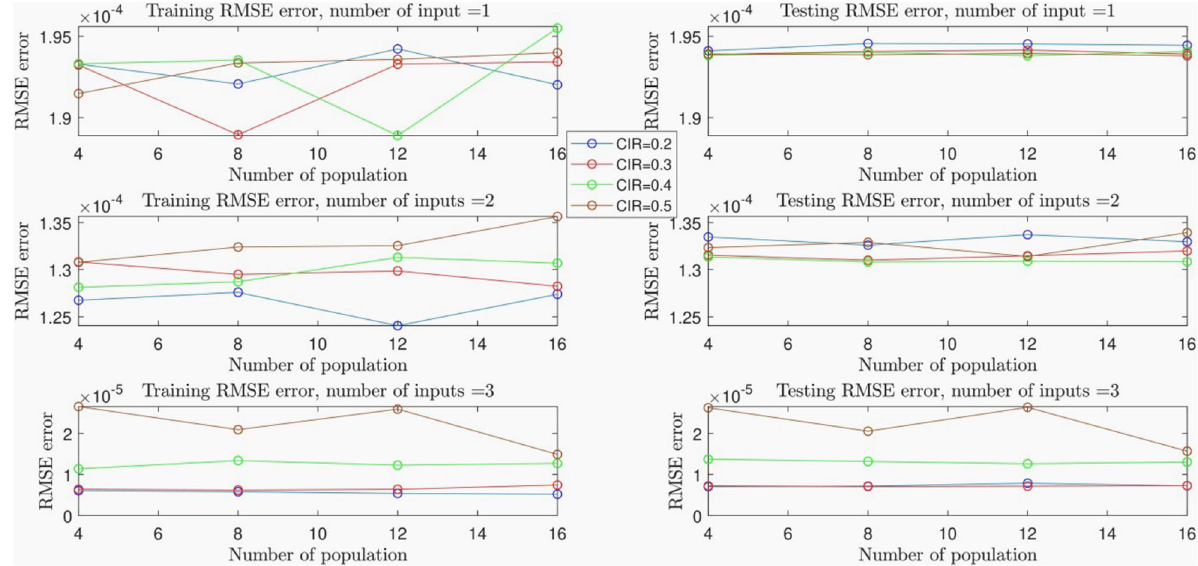
Figure 1. DEFIS learning processes with changes in the number of population as DE algorithm parameter and cluster influence range (CIR) as subtractive clustering parameter.